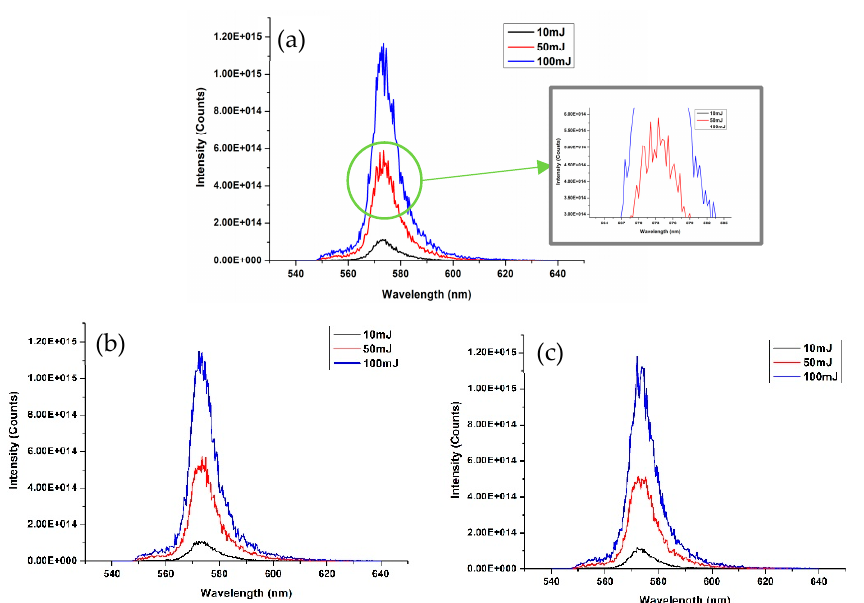
Figure 5. The emission intensity of a random laser based on almond milk with the variation of dye concentrations: ( a ) 10 − 2 M, ( b ) 10 − 3 M and ( c ) 10 − 4 M. The inset shows the multiple emission peaks in the close-up view.